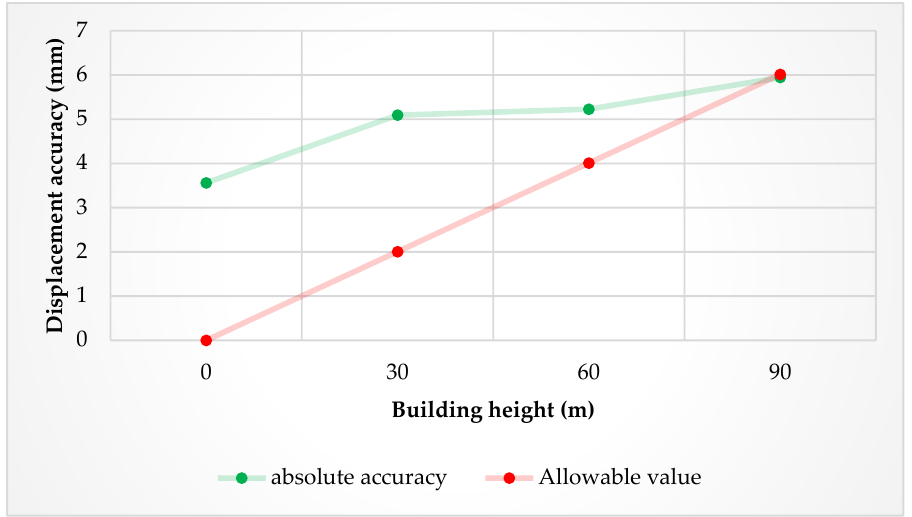
Figure 29. Simulation results comparison.